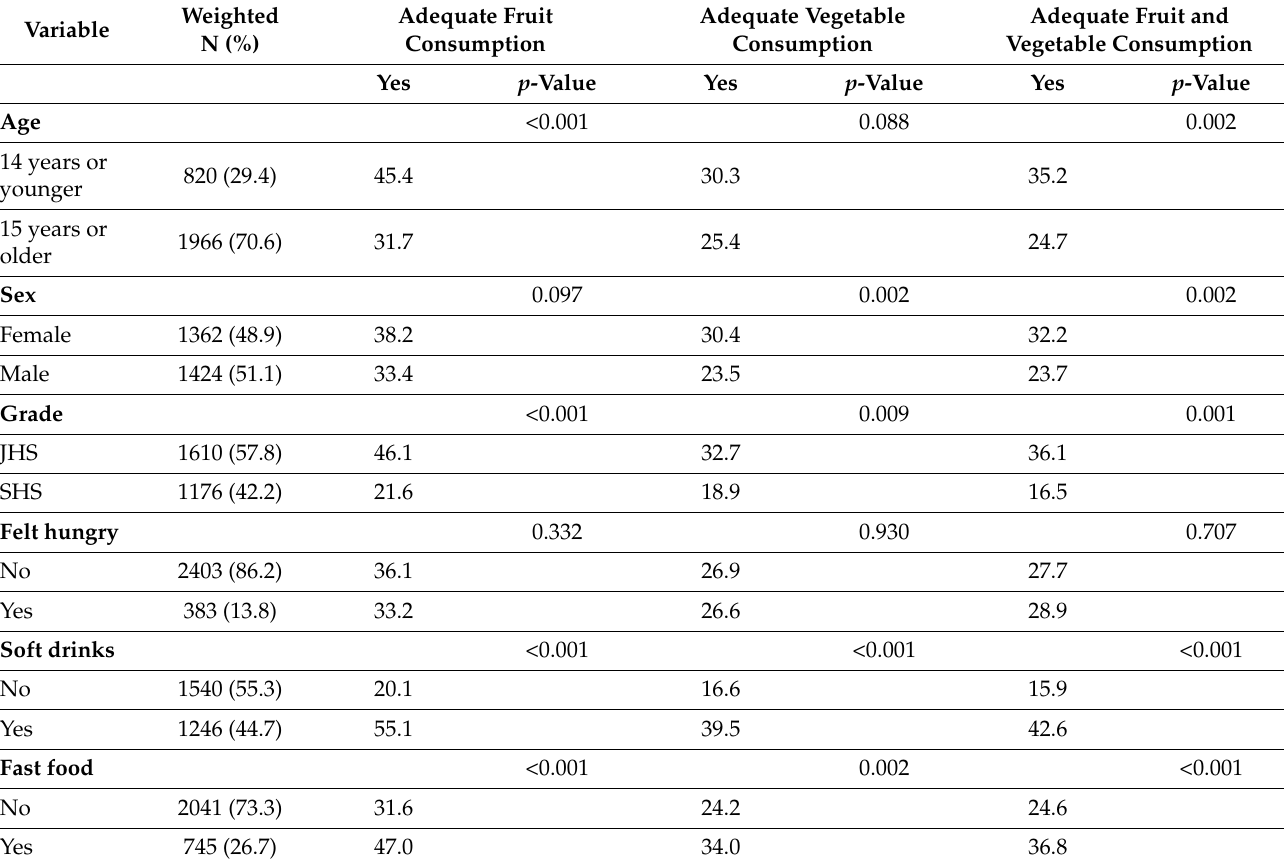
Figure 1. Prevalence of adequate fruit and vegetable consumption among the in-school adolescents in Ghana. Table 1. Bivariate analysis of proportions of adequate fruit and vegetable consumption among in-school adolescents in Ghana (N =